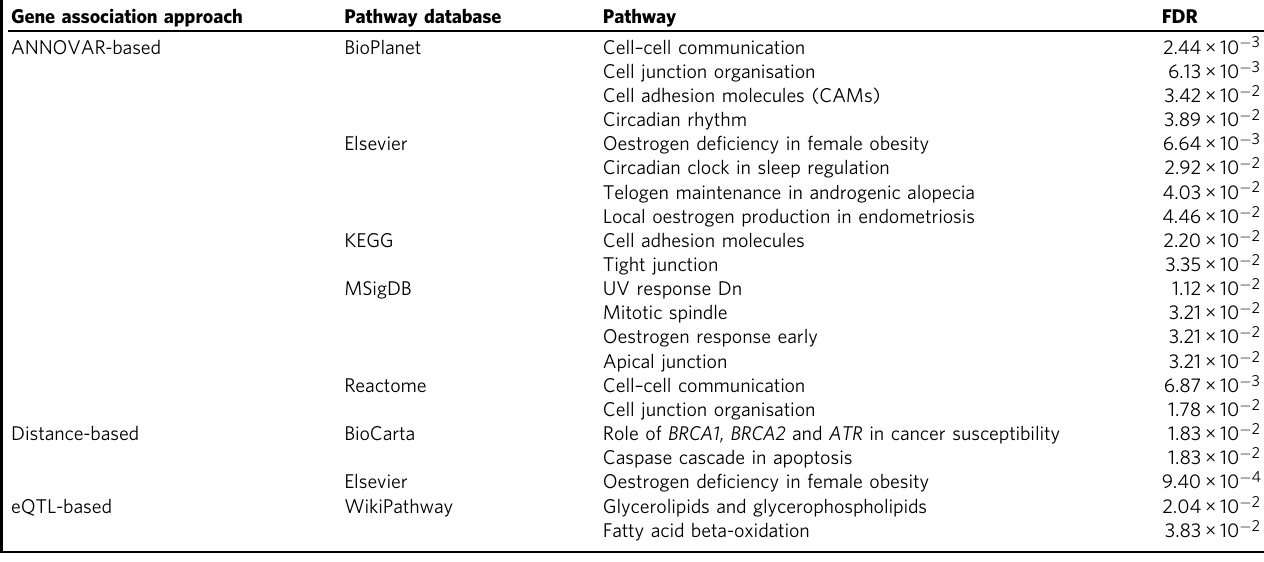
Table 1 Pathways of ANNOVAR-, distance- and eQTL-based differentially expressed genes associated with breast cancer CpGs.